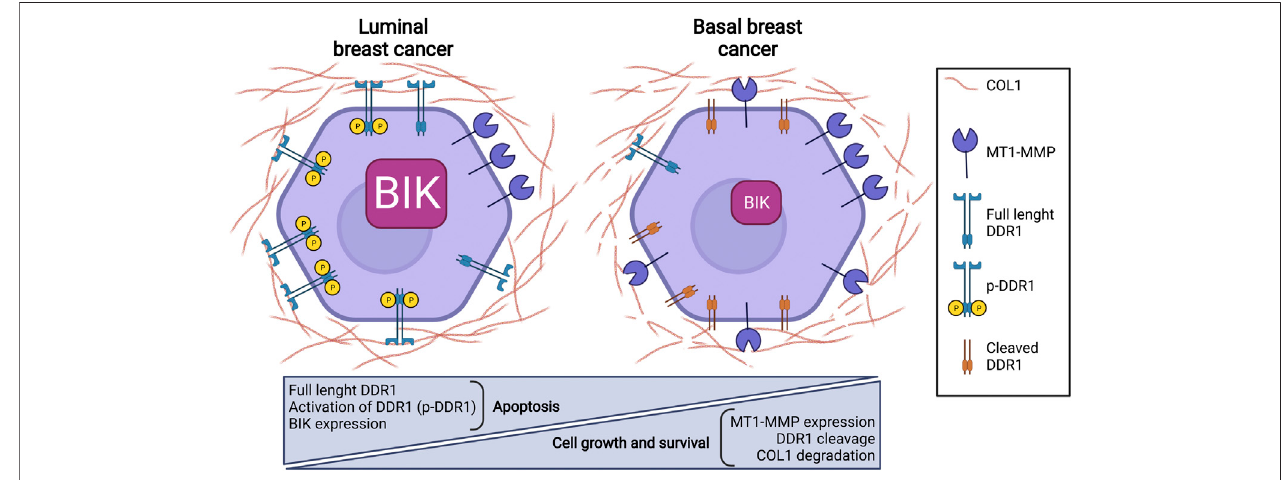
FIGURE 2 | MT1-MMP expression impairs DDR1-induced apoptosis in basal breast cancer cells.